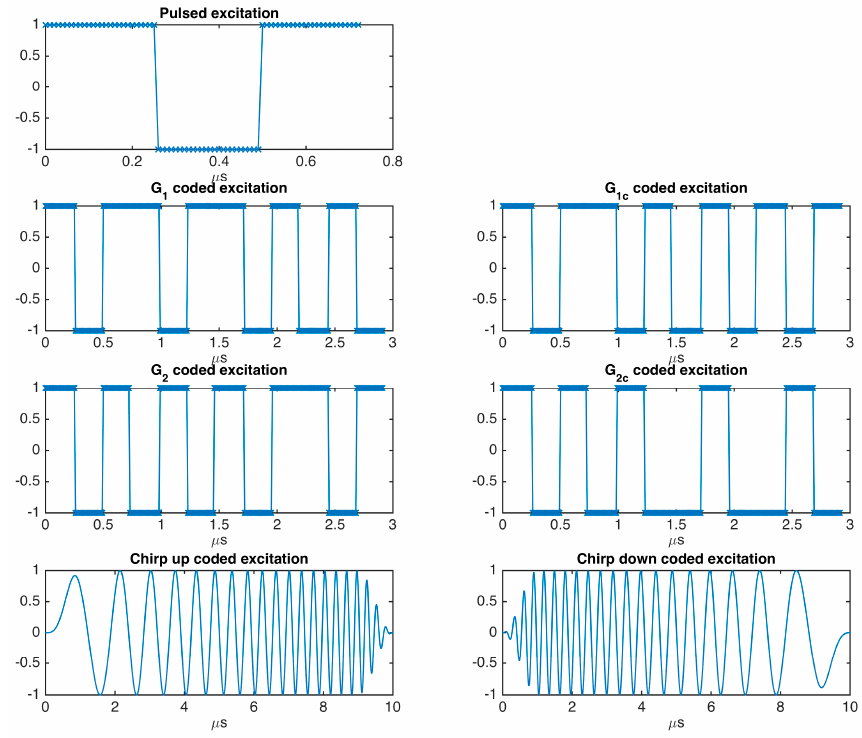
Figure 3. Plots of different excitation signals; G1: [1, 1, 1, -1]; G1c: [1, 1, -1, 1]; G2: [1, -1, 1, 1]; and G2c: [1, -1, -1, -1].